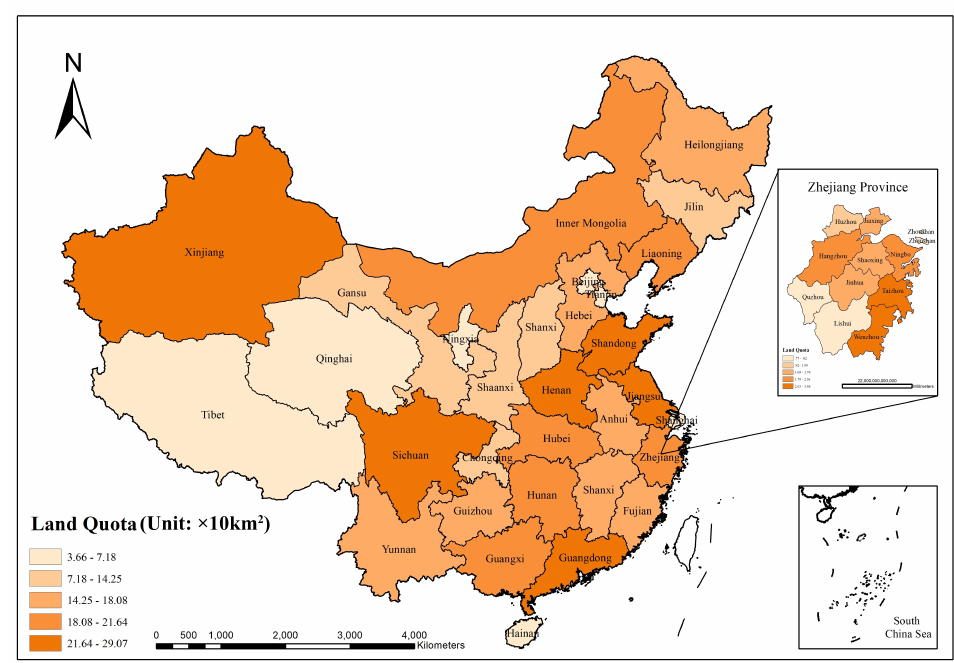
Figure 4. Spatial distribution of land quota in China and Zhejiang province